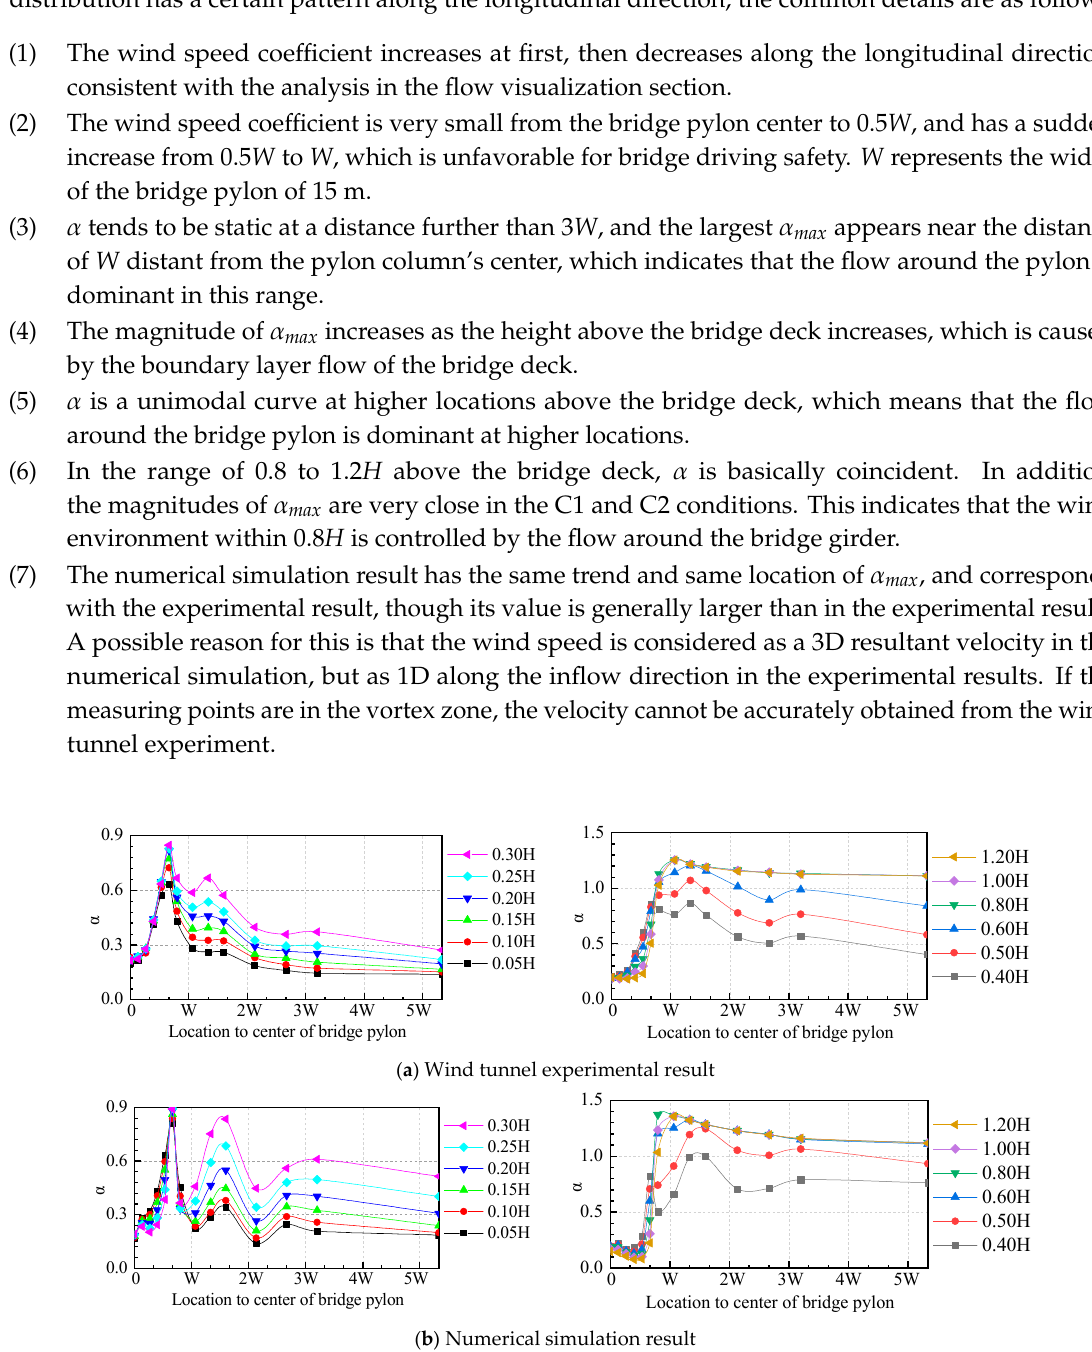
Figure 13. Wind speed coefficient at upstream main lane in C1 condition.